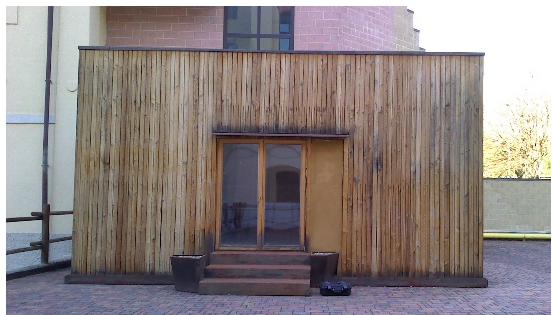
Figure 6. Pre-assembled prototype in Verrès (Aosta), Italy.